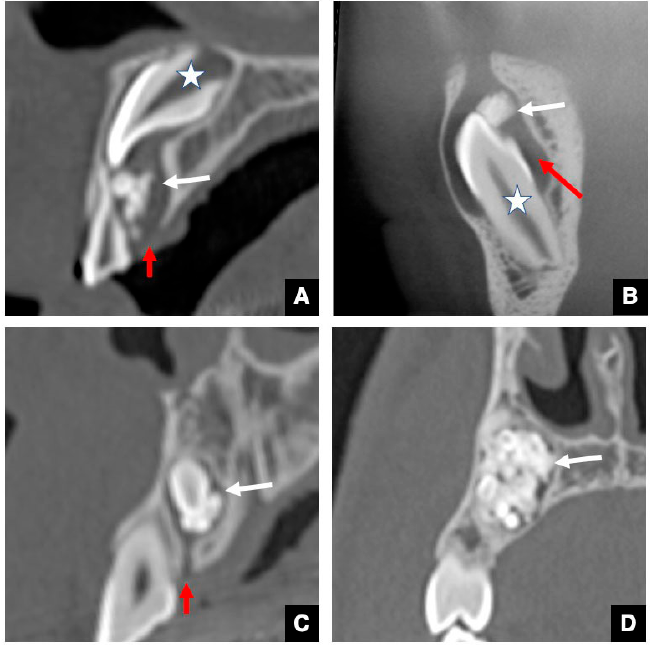
Figure 6. Typical spatial relationship between odontomas and GT or DS on CT. ( A ) CBCT image of the odontoma classified as Group 1. Odontoma (arrow) is detected within the GT (red arrow) of the unerupted permanent successor (star). ( B ) CBCT image of the odontoma classified as Group 2. Odontoma (arrow) is detected within the DS (red arrow) of the unerupted permanent successor (star). ( C ) CBCT image of the odontoma classified as Group 3. Odontoma (arrow) is not detected in either the GT or the DS of the unerupted permanent successor, but its own GT (red arrow) is present. ( D ) CBCT image of the odontoma classified as Group 4. The odontoma (arrow) did not have a GT.